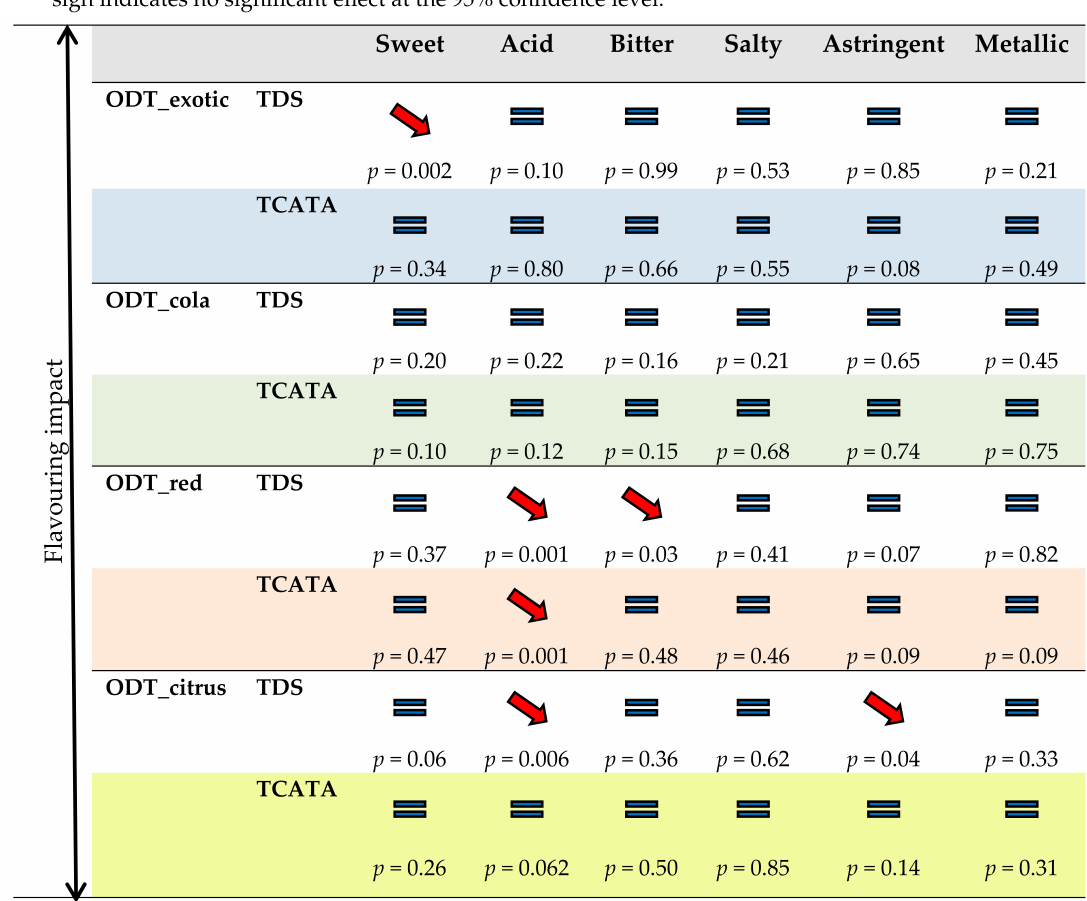
Table 3. One-way ANOVAs with evaluation type (with nose-clip and without nose-clip) as the independent variable and dominant citation / duration of attributes as the dependent variable to determine the flavoring impact on dominance and citation duration for each product and each attribute. A red downward arrow indicates a significant negative e ff ect at the 95% confidence level. A blue equal sign indicates no significant e ff ect at the 95% confidence